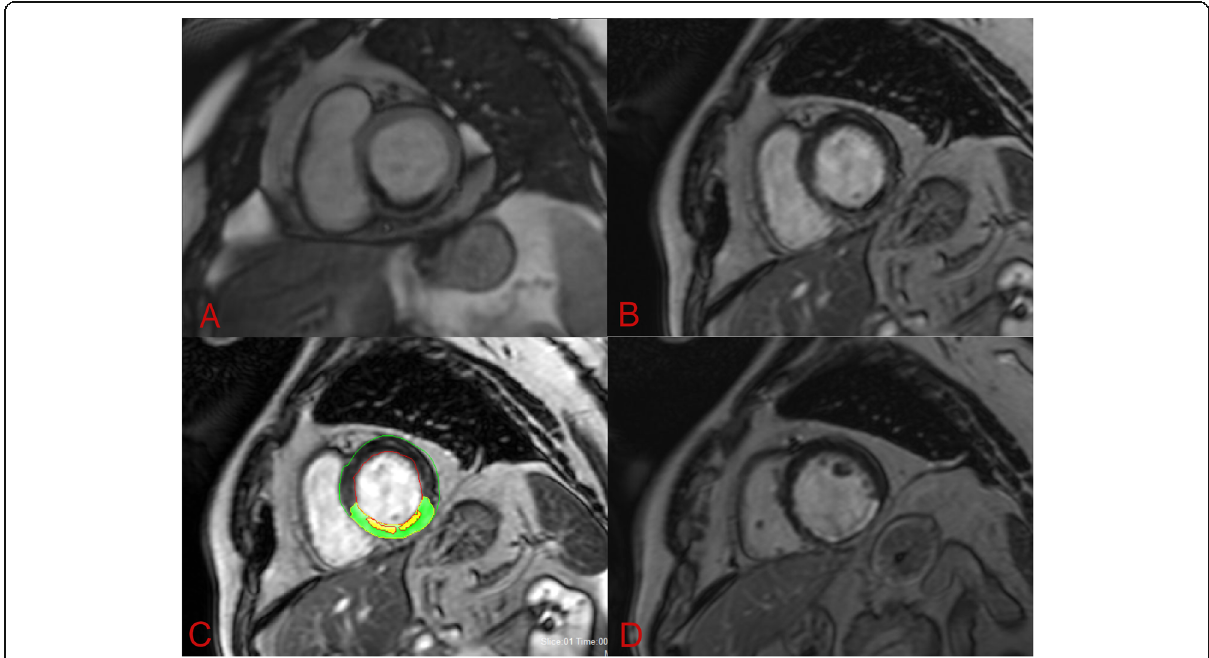
Fig. 6 a Cardiac MR performed for a patient 4days post-primary percutaneous coronary intervention. Short-axis EGE sequence at mid-ventricular level shows a sub-endocardial inferior and infero-septal left ventricular wall low signal corresponding to microvascular obstruction. b Corresponding short- axis LGE sequence showing transmural inferior and infero-septal left ventricular wall hyperenhancement/infarct with central low signal microvascular obstruction. Culprit lesion was detected at RCA. c Corresponding short-axis T1W LGE sequence with post-processing of the LV scar (green) and MVO (yellow) revealing an MVO size = 9% and infarct size = 27% of the total left ventricular mass (LVM). Follow-up short-axis LGE sequence, after 3months, showing transmural inferior and sub-endocardial infero-septal left ventricular wall fibrosis scar with complete resolution of the MVO